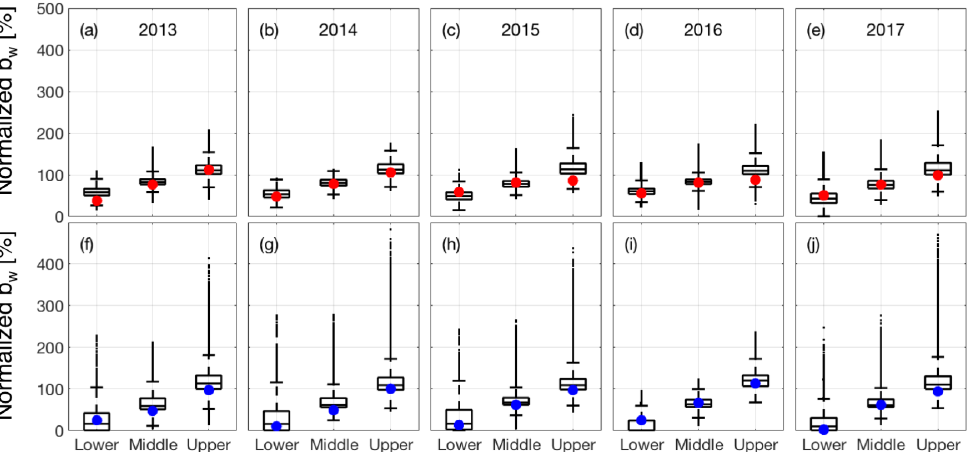
Figure 14. Spatial variability in snow accumulation for individual years (2013–2017) by elevation (lower, middle, upper) compared to stake measurements. Box plot of all distributed SWE values (from multivariable regression) for each index zone of the glacier for Gulkana (a– e) and Wolverine (f–j) for 2013–2017. The filled circles are the respective stake observation for that index zone. SWE is expressed as a percentage of the glacier-wide average, B w , for that year and